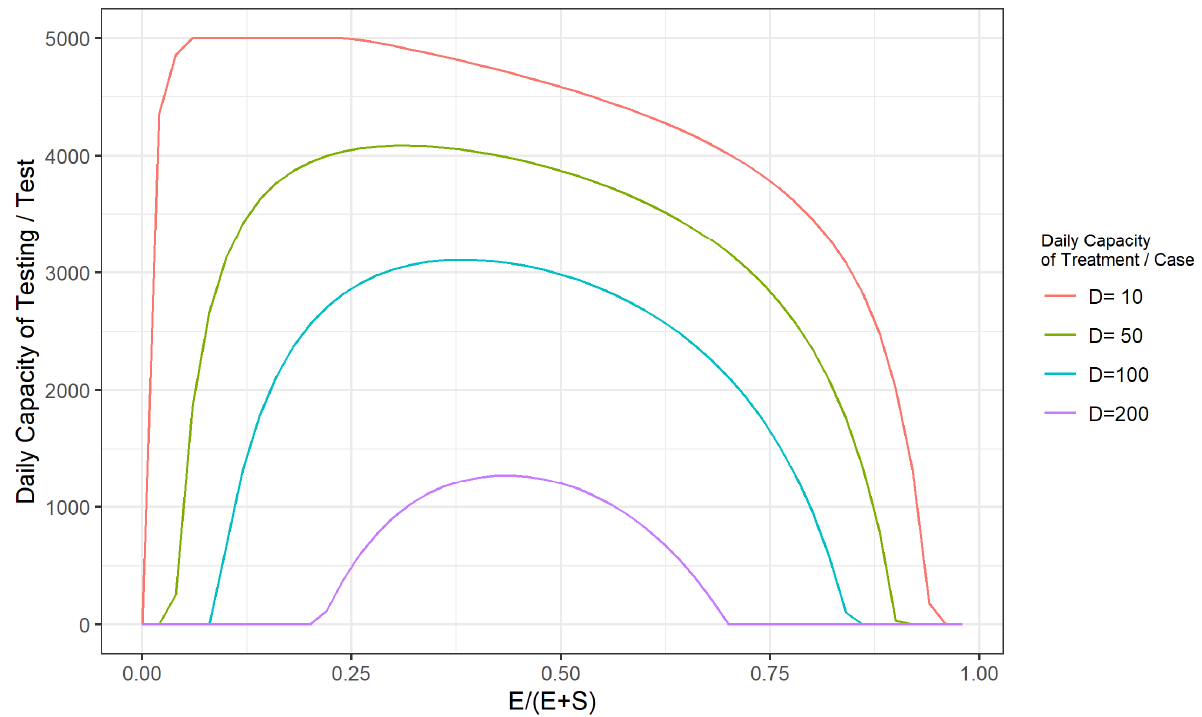
Figure A9. The effect of daily testing capacity on the ability to control the potential development level of the epidemic ( S + E =8000, I = 1000).